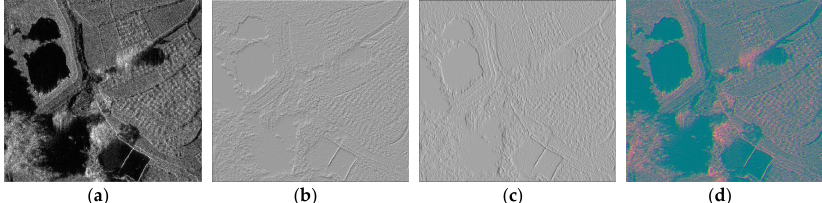
Figure 10. The results of Multi-scale Omnidirectional Gaussian Derivative Filter (MSOGDF). ( a ) SAR image. ( b ) MSOGDF characteristic of 45-degree. ( c ) MSOGDF characteristic of 135-degree. ( d ) the concatenation results of MSOGDF.